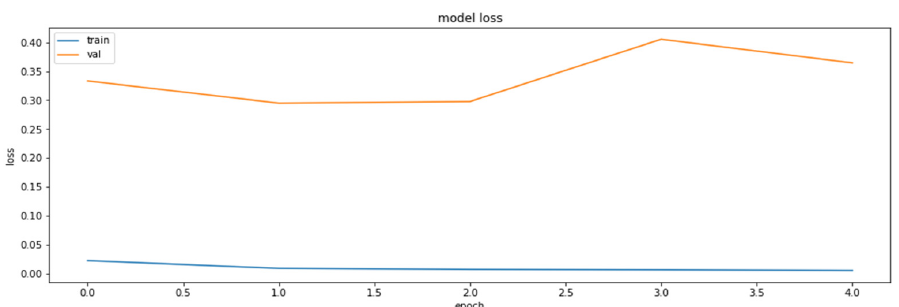
Figure A4. The accuracy of the model for the training and the validation datasets obtained during the training of the model with the weights clustered with the linear initialization of 32 centroids.